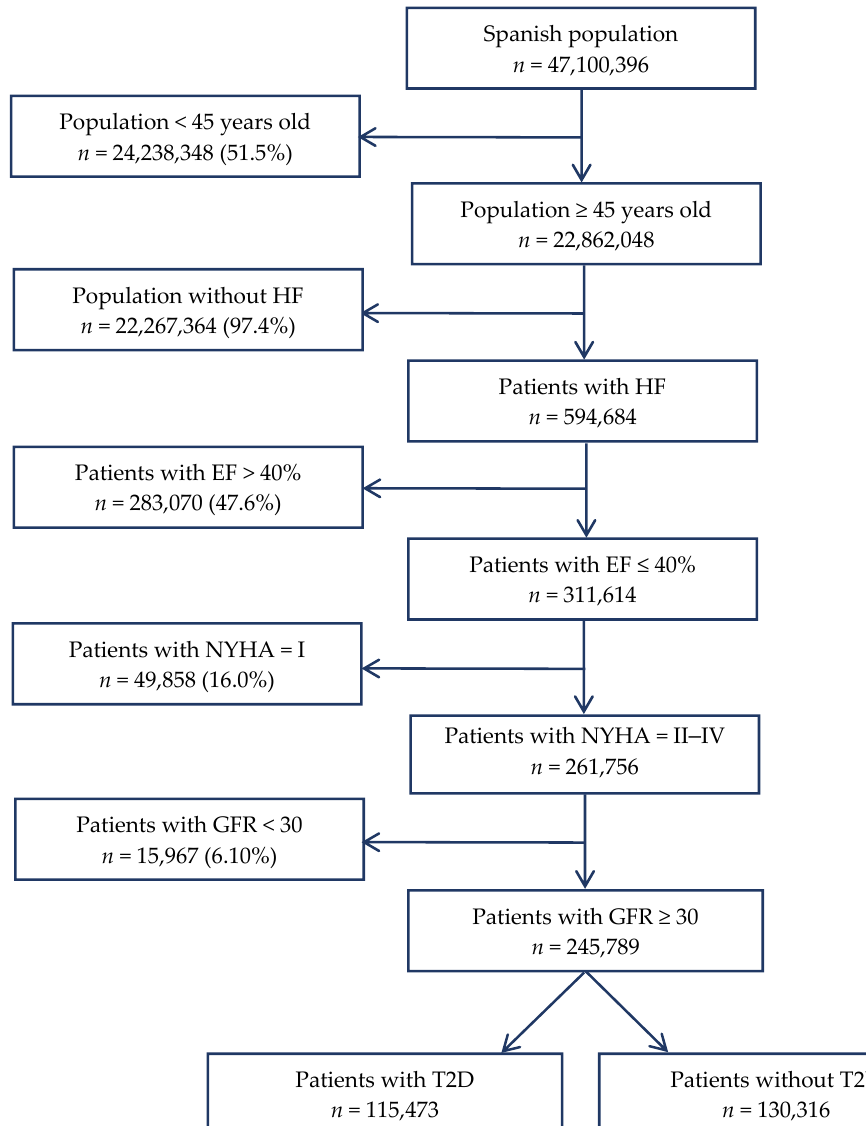
Figure 1. Flow chart of the Spanish population older than 44 years with heart failure (HF), ejection fraction (EF) ≤ 40%, New York Heart Association (NYHA) functional class II–IV, glomerular filtration rate (GFR) ≥ 30 mL/min/1.73 m², and type 2 diabetes mellitus (T2D), according to the estimation specified in the Methods section.